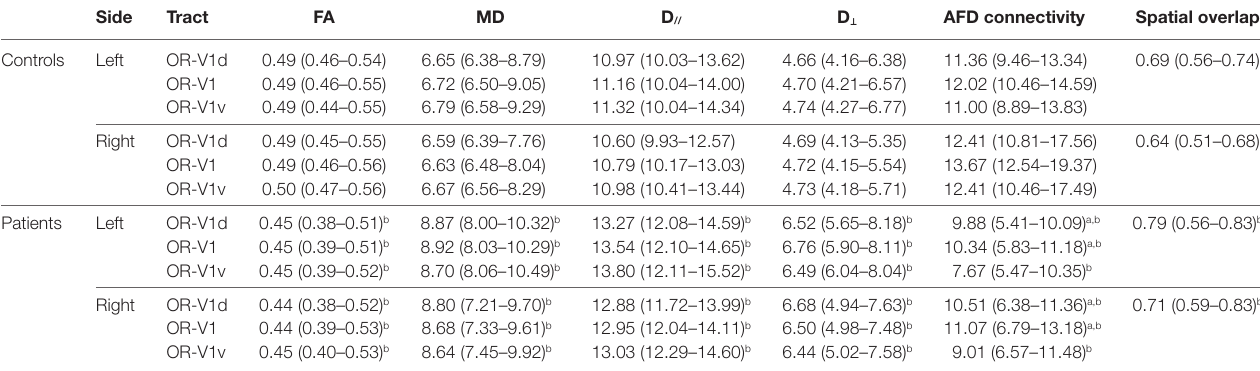
aFD connectivity spatial overlap ⊥